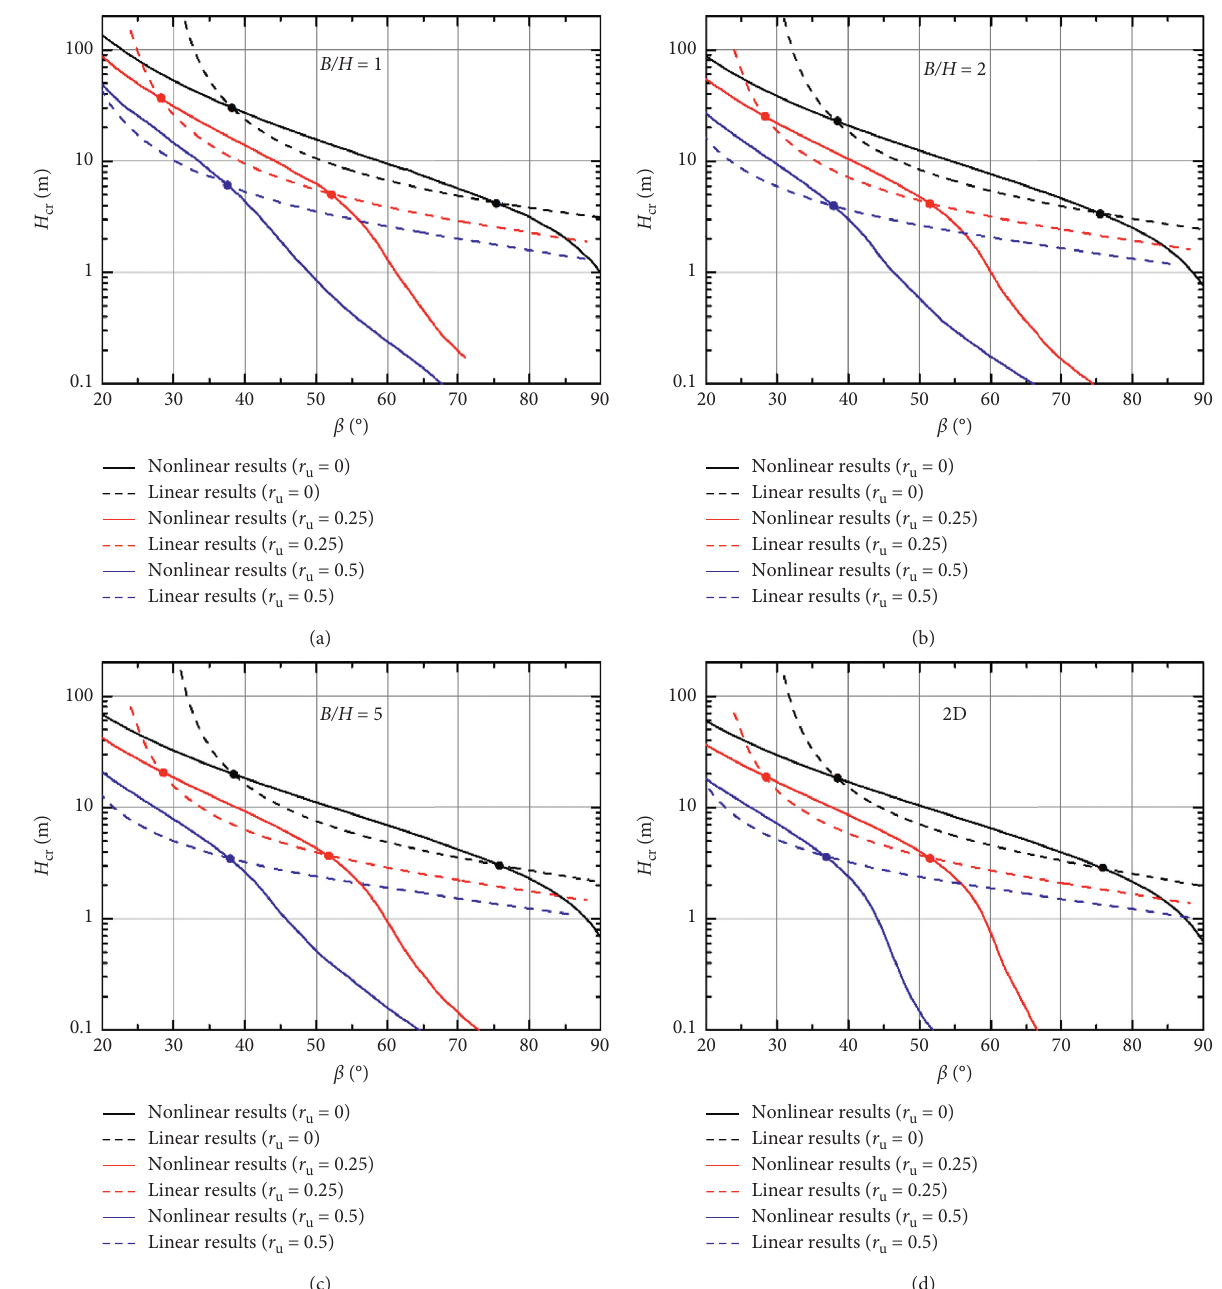
Figure 10: Critical heights of Oxford clay slopes undergoing different pore-water pressures. (a) B/H � 1. (b) B/H � 2. (c) B/H � 5. (d)